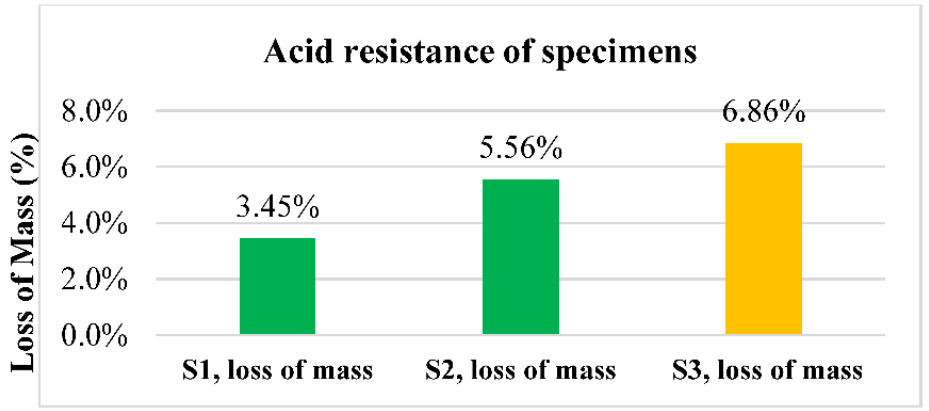
Figure 9. Results of acid resistance.